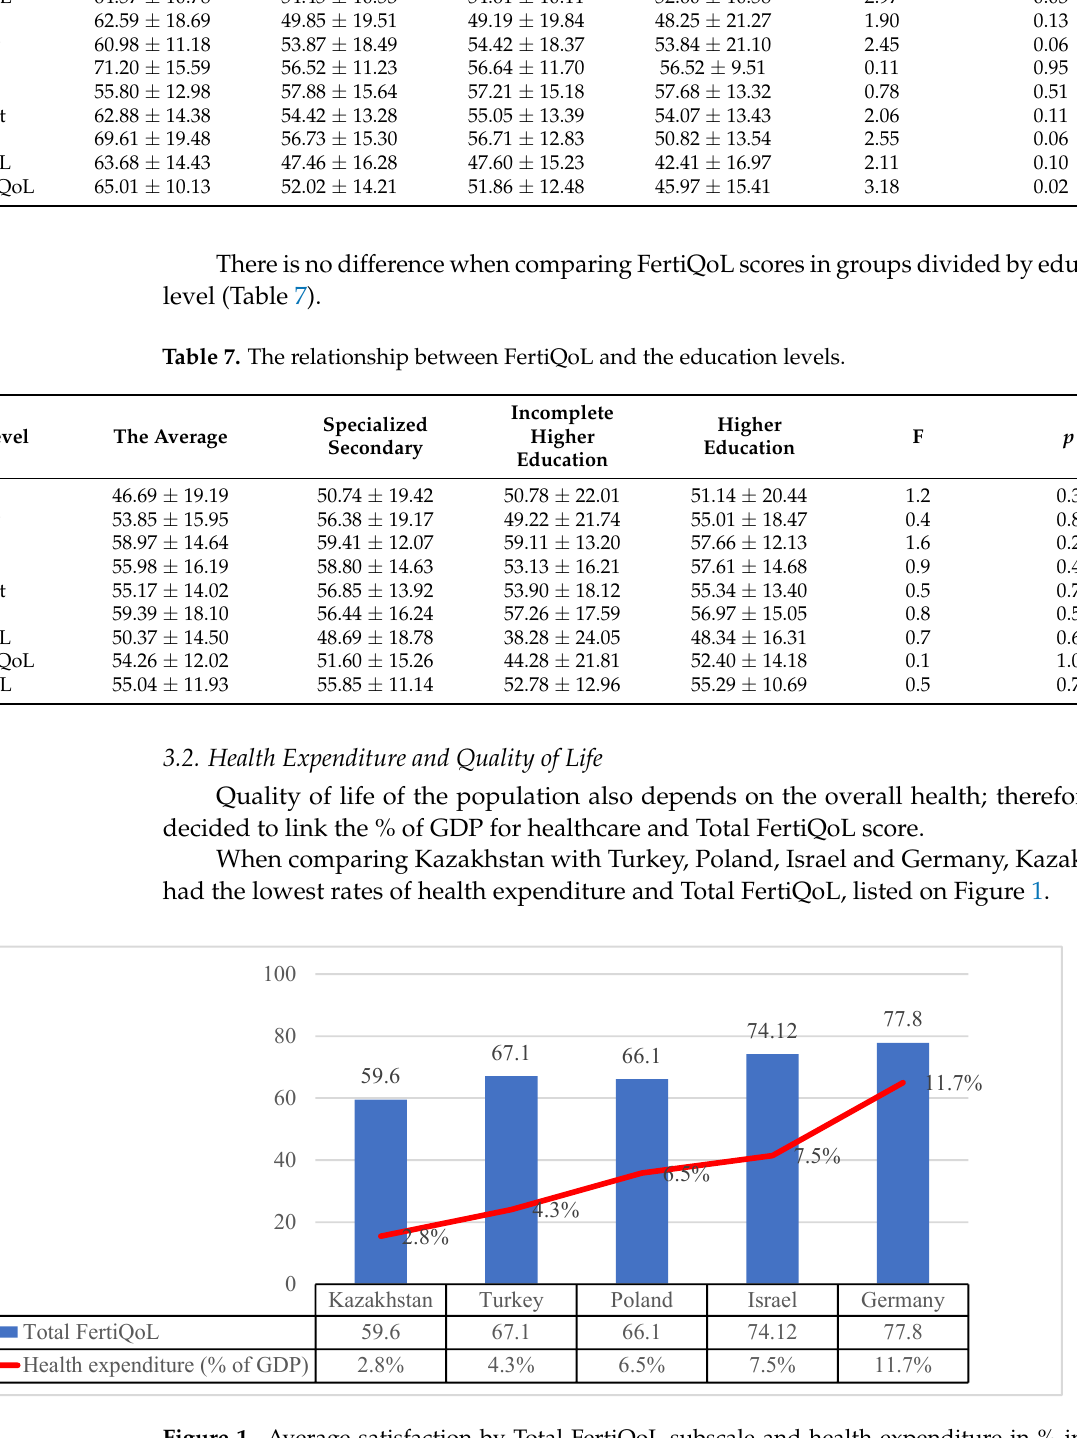
Figure 1. Average satisfaction by Total FertiQoL subscale and health expenditure in % in other countries from 2019 [22,23]. The data was obtained from the website: https://www.statista.com/ (accessed on 7 September 2022)